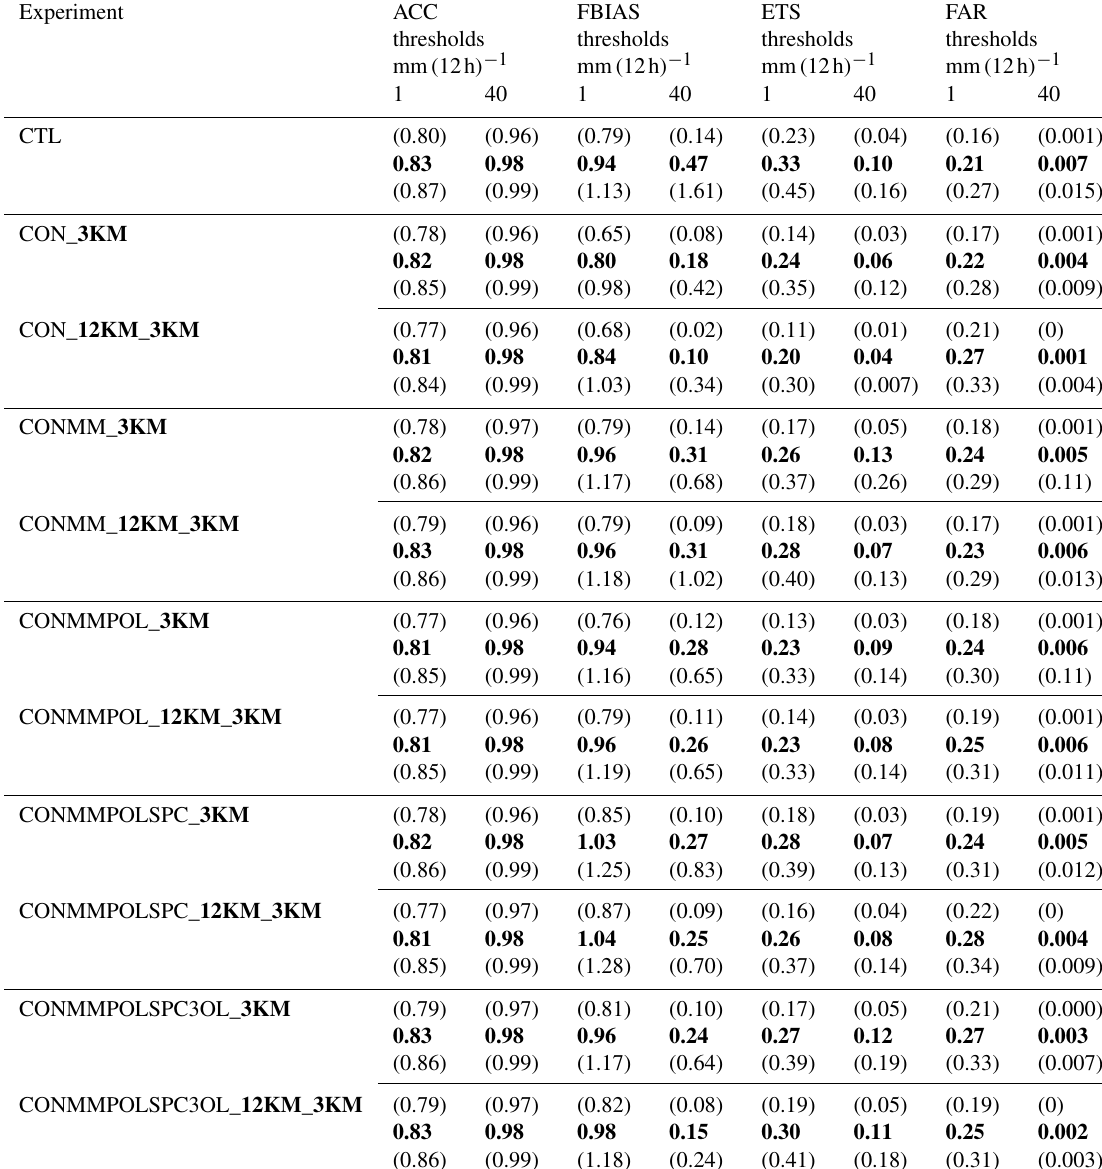
Table 3. Bootstrap 95% confidence intervals for verification statistics forecast accuracy (ACC), frequency bias (FBIAS), equi- table threat score (ETS), false alarm ratio (FAR), and referring to experiments in columns 2 and 3 of Fig. 7, respectively. They are considered as a function of thresholds (1 and 40mm ( 12h ) − 1 ). The experiments are CTL, CON_3KM and CON_12KM_3KM, CONMM_3KM and CONMM_12KM_3KM, CONMMPOL_3KM and CONMMPOL_12KM_3KM, CONMMPOLSPC_3KM and CON- MMPOLSPC_12KM_3KM, CONMMPOLSPC3OL_3KM and CONMMPOLSPC3OL_12KM_3KM. The numbers in bold font represent the value between bootstrap upper and lower confidence